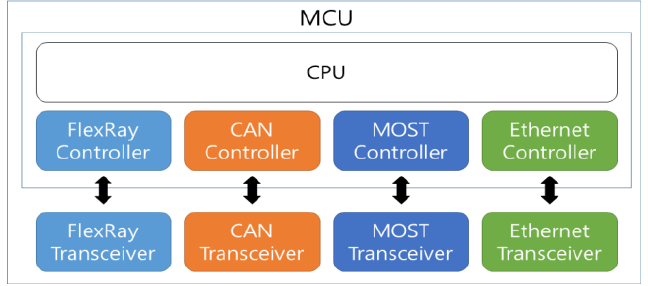
Figure 3. The block diagram of the hardware devices.